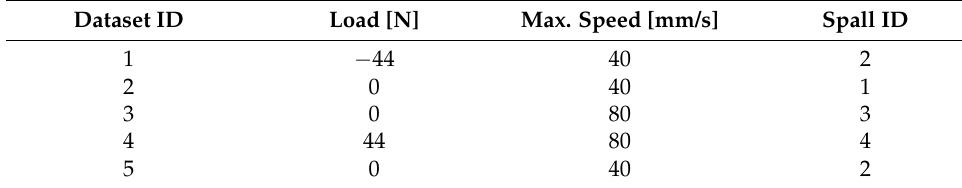
Table 3. EMA datasets used in the